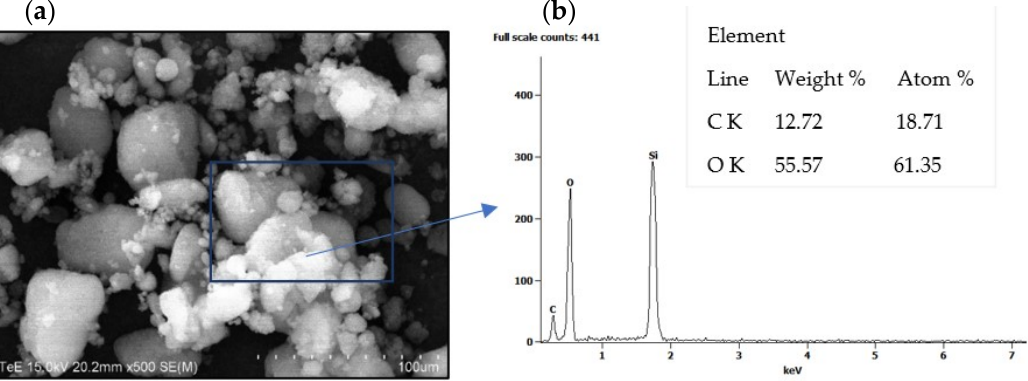
Figure 8. The Aerosil 300 silica thickener ( a ) SEM image over ×500 and ( b ) EDS spectrum with elemental analysis.